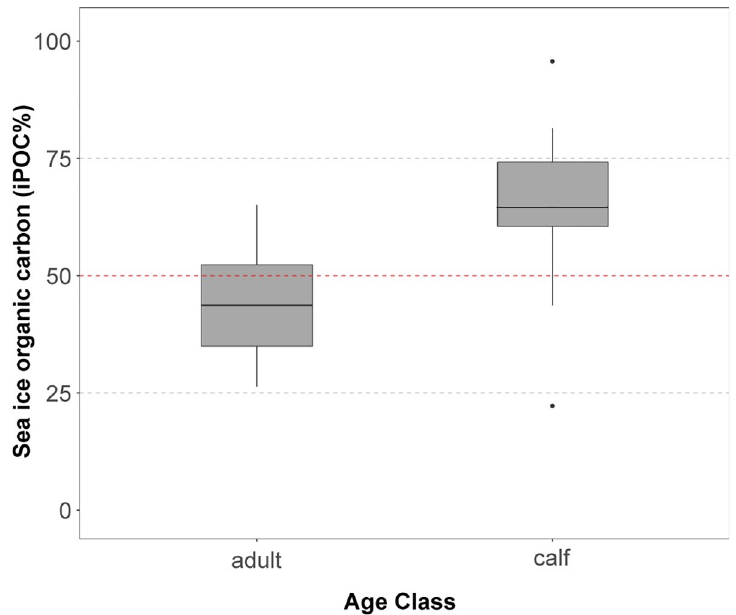
Fig 6. Sea ice organic carbon (iPOC%) by age class in the Chukchi Sea. Box plots represent the interquartile range of values for adults ( n = 9) and calves ( n = 7) in the Chukchi Sea. The red-dashed line indicates the 50% sea ice organic carbon threshold, with values above this level suggesting elevated sea ice organic carbon contributions to the Pacific walrus